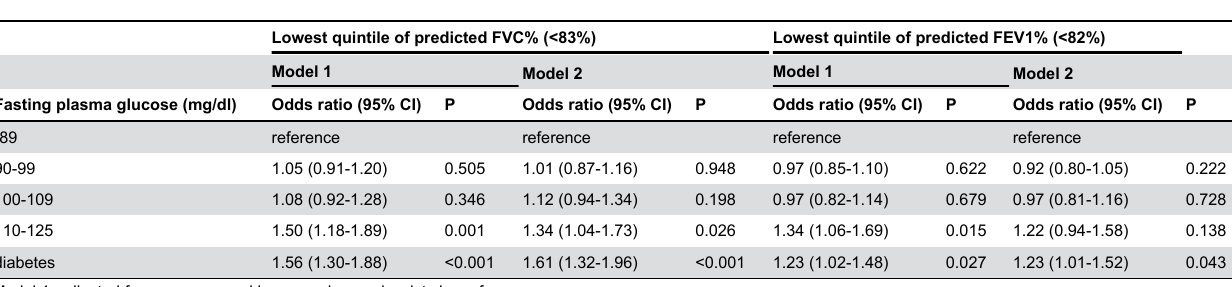
Model 1: adjusted for age, sex, smoking, exercise, and waist circumference Model 2: model 1 after exclusion for individuals with diagnosed history of chronic obstructive pulmonary disease, or bronchial asthma, or coronary heart disease, or cerebrovascular accident, or cancer doi: